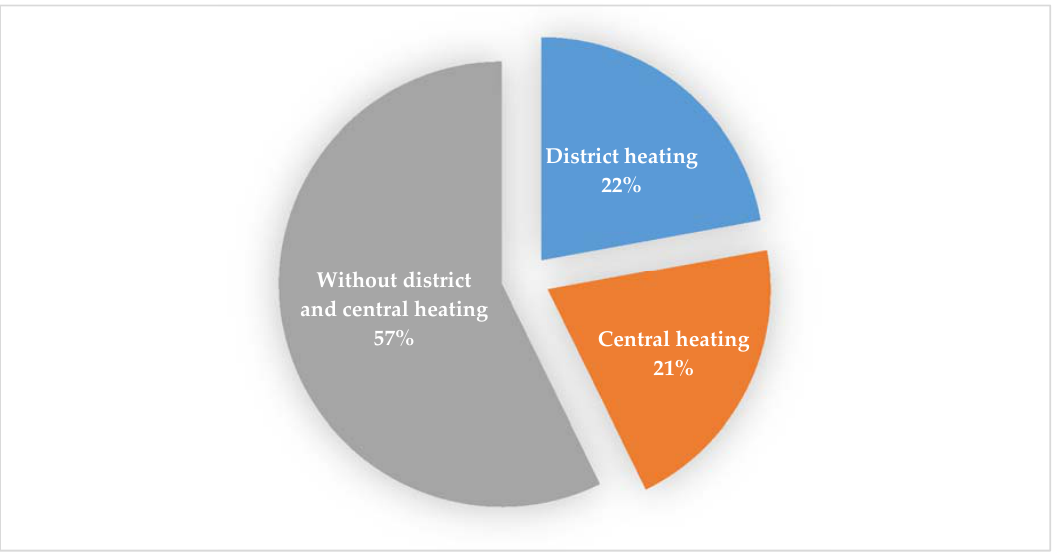
Figure 1. Occupied dwellings according to the type of heating in the Republic of Serbia. The graph is altered by rounding up the values [65] (p. 19).